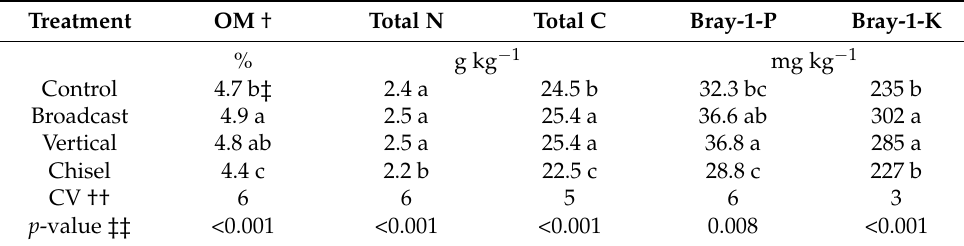
Table 1. Treatment averages for select soil nutrient characteristics.